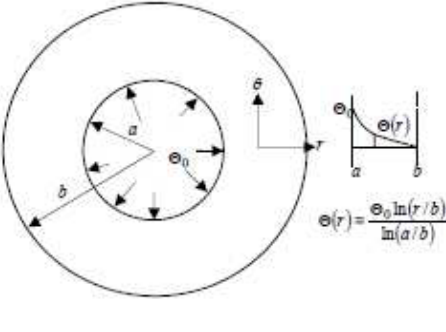
Figure 1. Geometry of